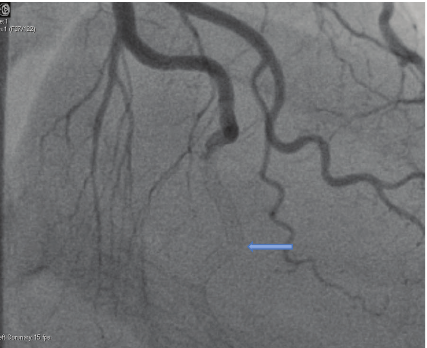
Figure 6: Possible stent fracture (arrow) in distal LAD during second